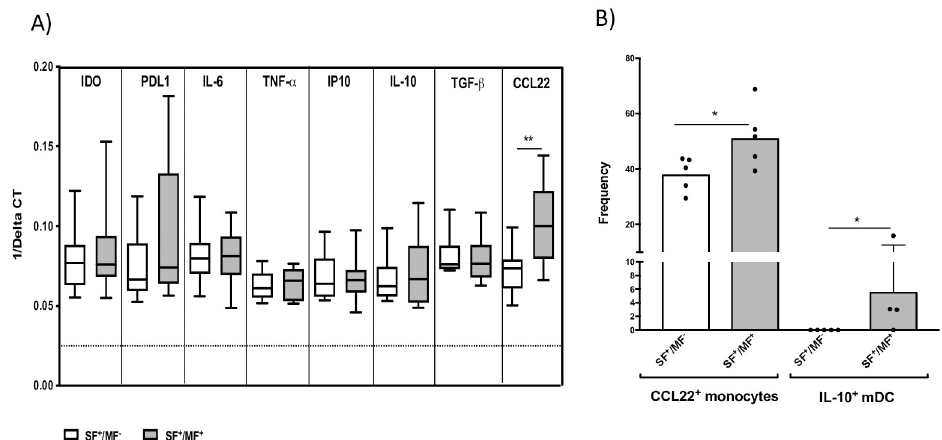
Fig 4. mRNA expression of CCL22 and the frequency of CCL22 + monocytes and IL-10 + mDC is higher in SF + / MF + than SF + /MF - individuals. A) Monocytes from PBMCs of SF + /MF + (n = 11) and SF + /MF - (n = 10) individuals were isolated and cultured in media for 24 hours. Cells were harvested, and A) mRNA levels were measured by TaqMan real-time PCR and normalized to the levels of 18S rRNA. Results are shown as geometric mean of 1/average Δ CT and graphed as boxes and whiskers (with minimum and maximum; there is no mRNA detection below 0.0277 (the dotted line). B) Whole blood from SF + /MF + (n = 5) and SF + /MF - (n = 5) individuals were RBC-lysed and cultured in media alone for 24 hours. Cells were harvested and the frequency of intracellular CCL22 + cells in CD14 + /HLA-DR + monocytes IL-10 + cells in HLA-DR + /CD11c + /CD123 - mDCs were measured by flow cytometry. Bars represent geometric mean of frequency in SF + /MF + (n = 5) and SF + /MF - (n = 5). Statistical difference in between the two groups are measured using nonparametric Mann- Whitney test; � ( p <